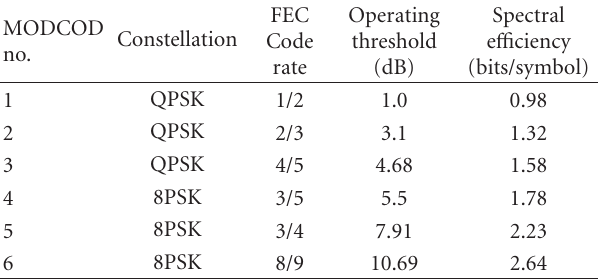
Table 1: MODCOD combinations used.